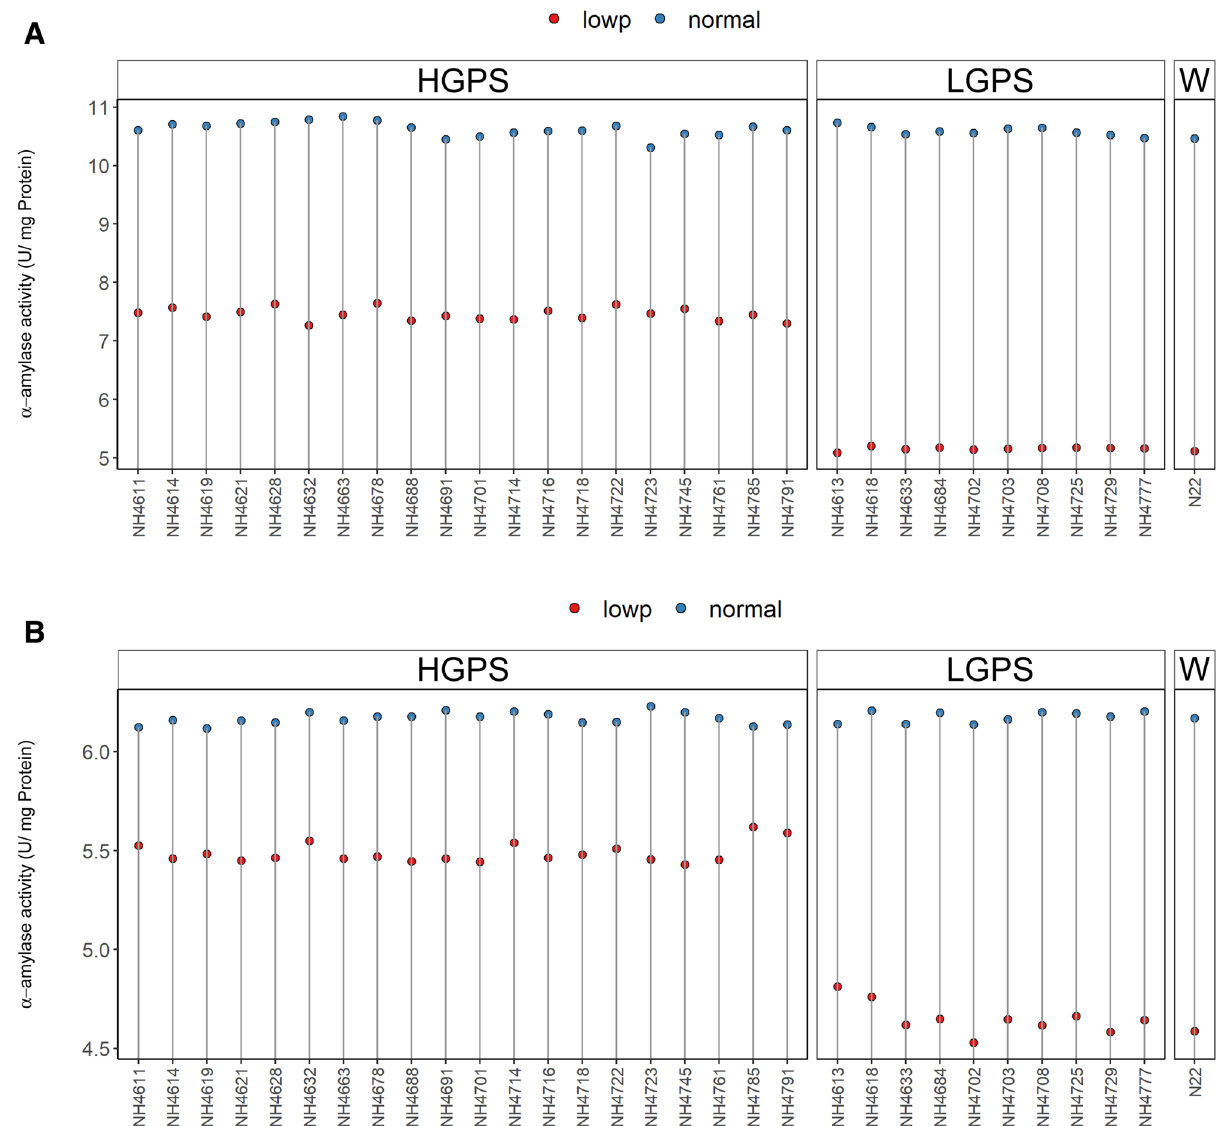
Figure 15. Alpha amylase enzyme (AAE) activity of seedlings obtained from germination of seeds harvested from low P (shown as red dots) and normal P (shown as blue dots) fields. Wild type N22 (W), high grain P mutant seedlings (HGPS), and low grain P mutant seedlings (LGPS) were grown under normal P condition. ( A ) AAE activity at 4 days of germination. ( B ) AAE activity at 8 days of germination. The values represent the mean of 10